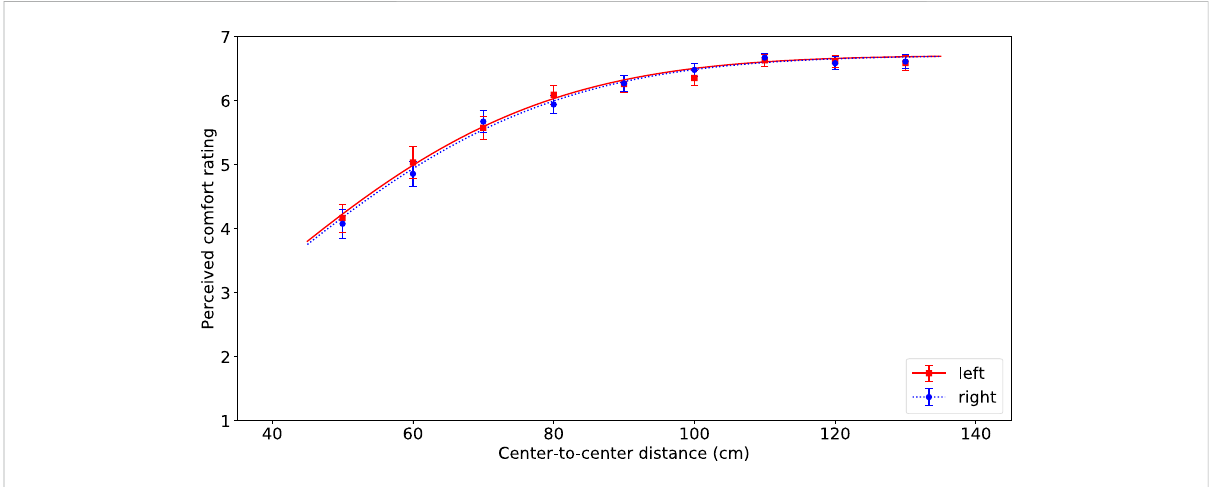
FIGURE 3 Visualization of the average comfort level per passing distance for the robot passing on the left (red squares) and right (blue circles) of the participant. The errorbarsrepresent Standard Error.The linesindicate thebest fi ttinginverted Gaussian, solidredlinefor leftanddashedbluelinefor right.